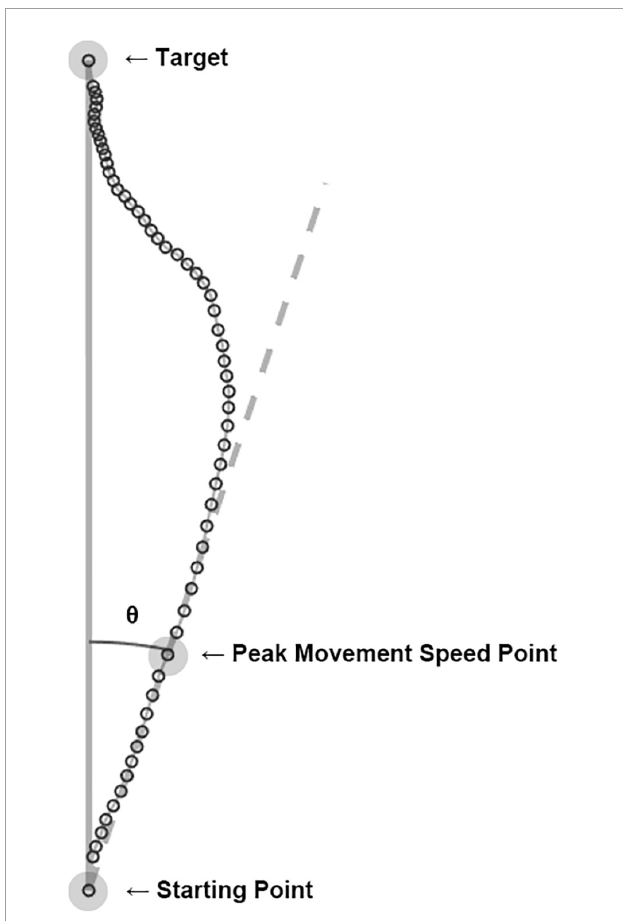
FIGURE2 Computation of heading angle error. The cursor’s real-time positions (open circles) were connected to become a hand movement trajectory of each trial. The peak movement speed point of each trajectory was calculated, and a line (dashed line) from the starting point to the peak movement speed point represents the movement’s heading. The angle between the movement’s heading and the ideal trajectory (solid line) was computed as the heading angle error. The example shown here is an actual trial of a participant in the